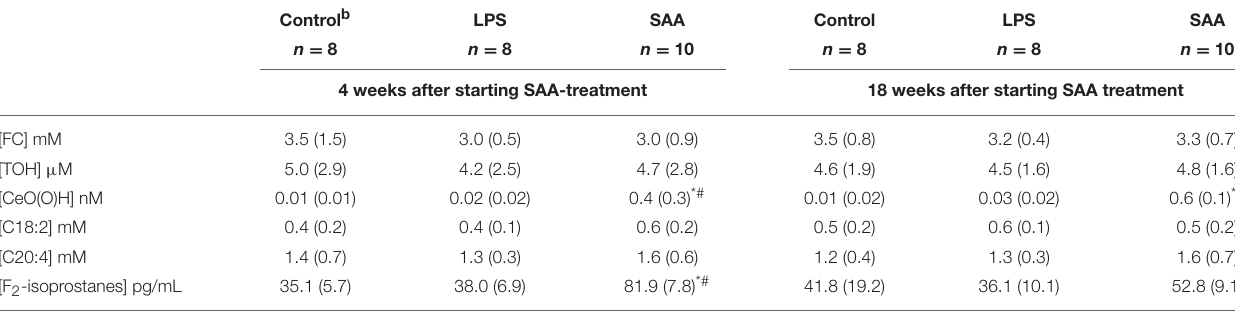
TABLE 2 | Plasma concentrations of native and oxidized lipids and vitamin E a .